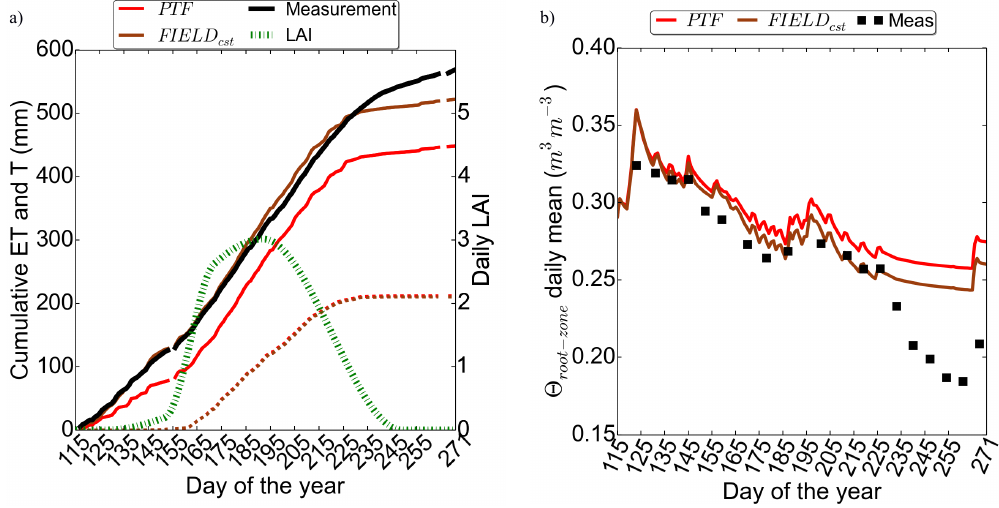
Figure 6. Evolution of (a) measured and simulated evapotranspiration (ET) and (b) measured and simulated root-zone soil moisture ( θ root-zone ) over the irrigated maize in 2001. In (a) the simulated transpirations ( T ) are represented by dashed lines and ET by solid lines. The LAI cycle is represented by green dash-dot lines.